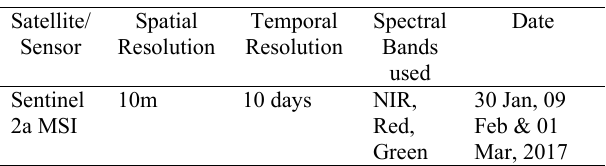
Table 1. Satellite Data Used